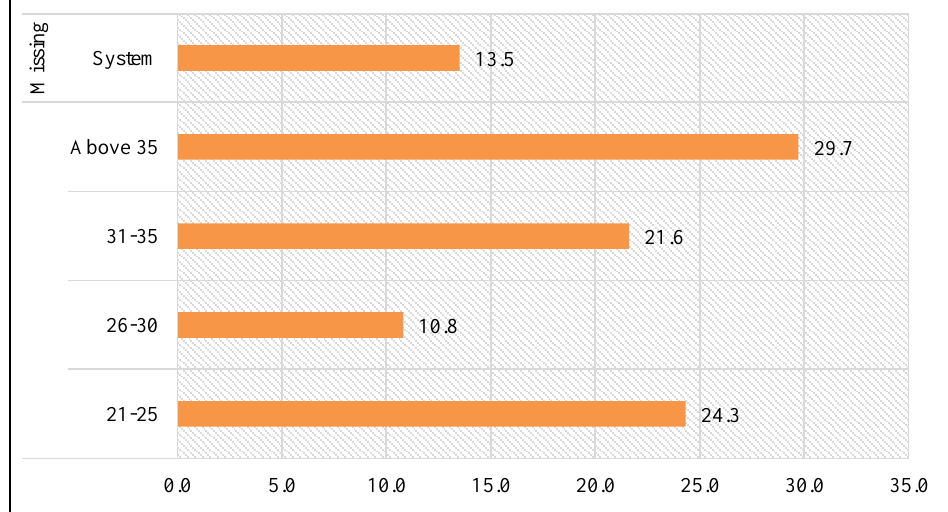
Figure 3. Age of the respondents in years (%)